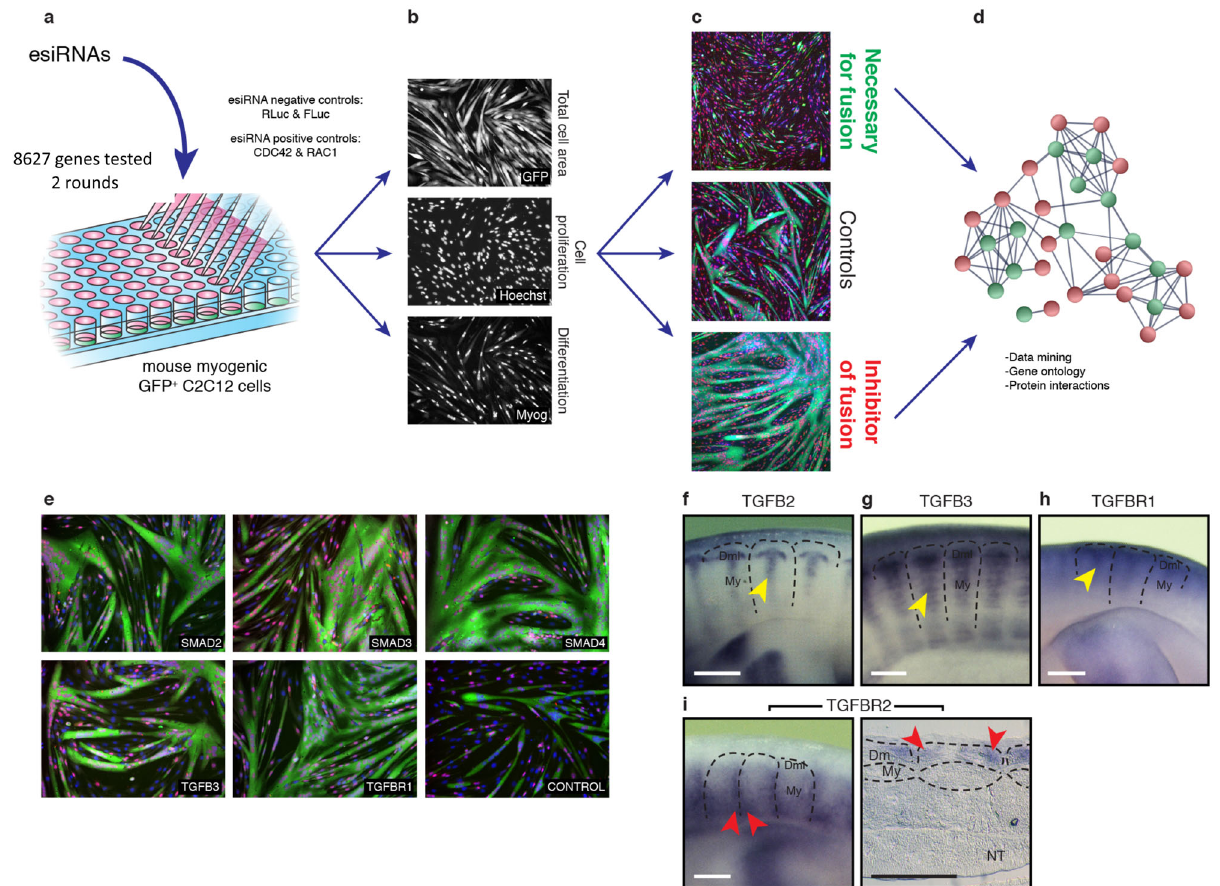
Fig. 1 TGF β signalling inhibits C2C12 fusion, and is expressed in the chicken embryo. a EsiRNAs corresponding to 8627 distinct mouse genes were transfected into a (GFP-positive) C2C12 mouse muscle cell line to identify novel molecules regulating myoblast fusion. b After differentiation, the area of myo fi bres (GFP staining), the nuclei count (Hoechst) and myogenin expression were evaluated with an image analysis program. c Quanti fi cation of the number of nuclei per myo fi bre identi fi ed a number of genes that are either necessary or inhibit myoblast fusion in vitro, compared to controls. d Gene ontology (Panther) and protein interaction (String) analyses showed that the TGF β pathway is over-represented within the inhibitors of fusion. e Loss of function of ligands, receptors or effectors of the TGF β pathway led to a strong increase of C2C12 fusion, compared to controls. f – h Lateral view of whole- mount (WM) in situ hybridization of chicken embryos at E5.5. The secreted ligands TGFB2 and TGFB3, as well as TGFBR1 are expressed in the myotome of the chicken embryo (yellow arrowheads, f – h ). i In contrast, TGFBR2 is expressed in epithelial cells located at the anterior and posterior borders of the dermomyotome (shown in WM and longitudinal section of chicken embryos at E5.5, red arrowheads). Dm: dermomyotome, My: myotome, NT: neural tube. Scale bars f – i : 0.5